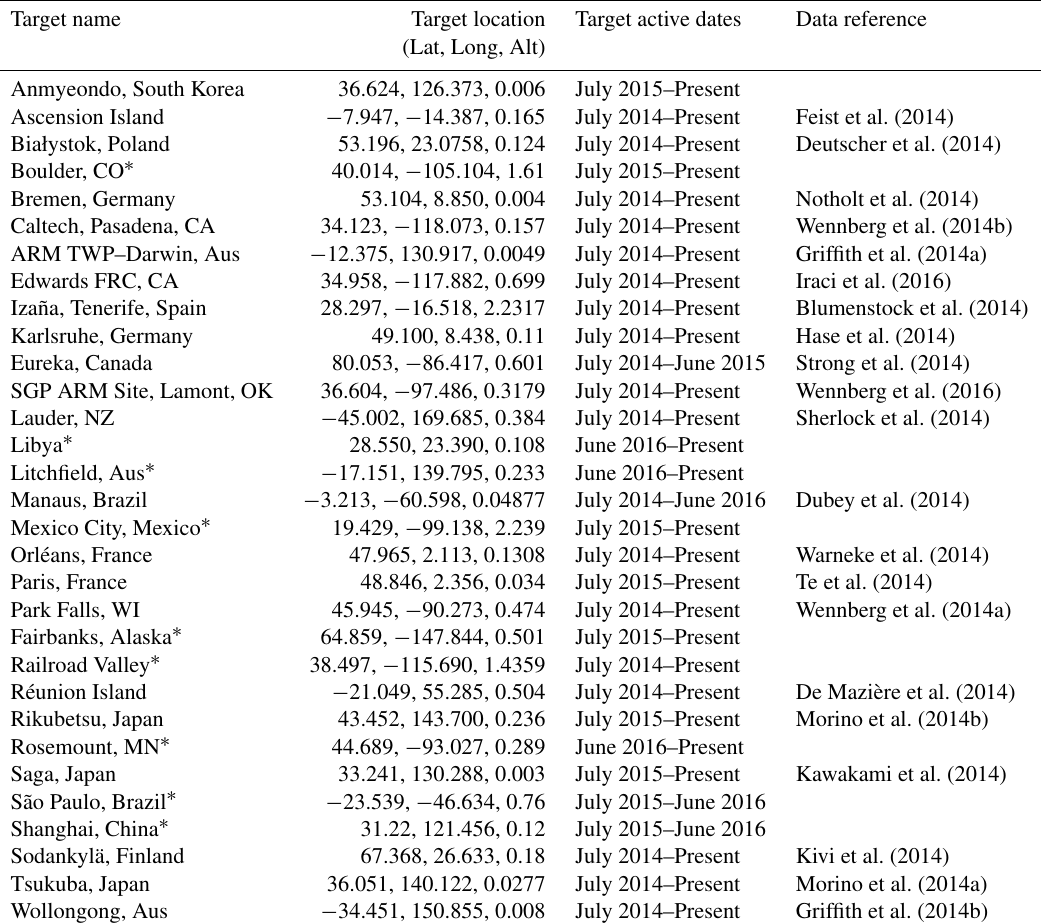
Table 1. Available targets. Note that the target location (listed in degrees latitude, degrees longitude, and altitude above sea level in km) may not be exactly centered on a TCCON site location. Targets without a corresponding TCCON station are marked with a star ( ∗ ) and are not discussed in this